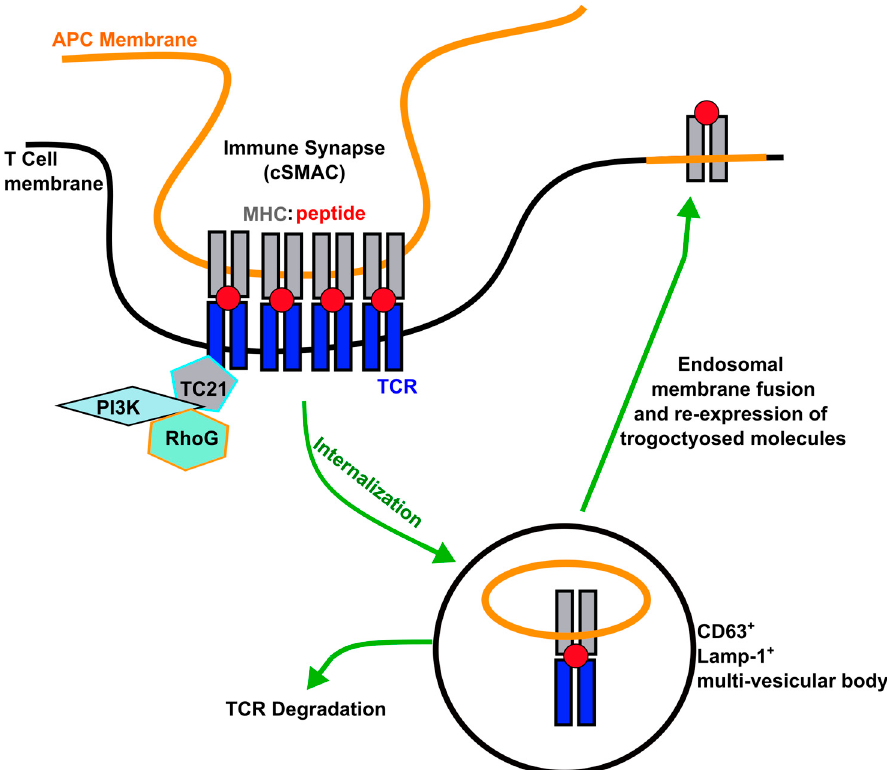
Figure 1. Model of trogocytosis event. T cells phagocytose APC membrane and membrane molecules from central Supramolecular Complex (cSMAC) of the immune synapse in a TC-21- and RhoG-dependent mechanism. The trogocytosed molecules traffic through multivesicular bodies where the TCR is sorted for degradation, and the endosome membrane fuses with phagocytosed APC membrane. The trogocytosed molecules traffic the plasma membrane for re-expression. Modified from [75,94].